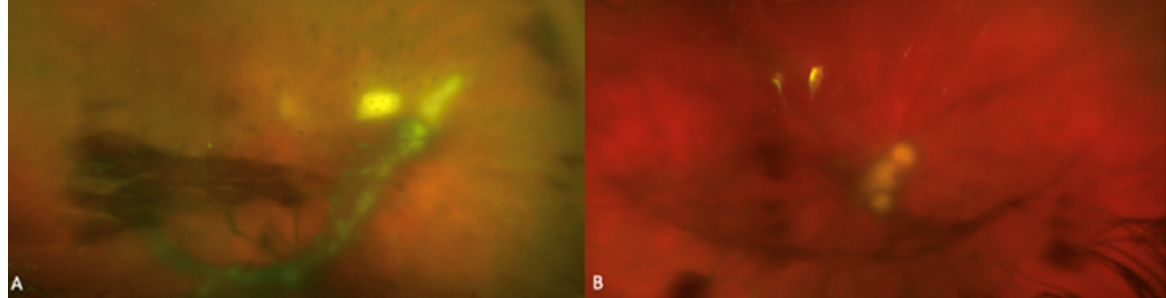
Figure 3. Fundus photographs of two patients with fungal endophthalmitis with ( A ) characteristic creamy-white and ( B ) well circumscribed “string of pearls” retinal and vitreous opacities.